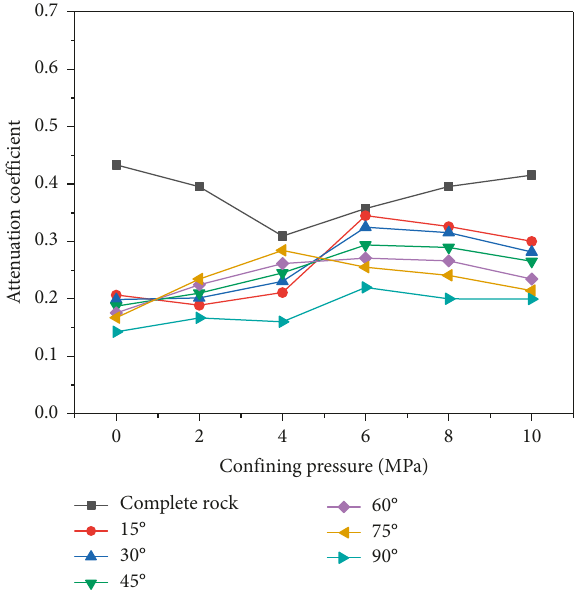
Figure 15: Variation of the stress attenuation coefficient with confining pressures.